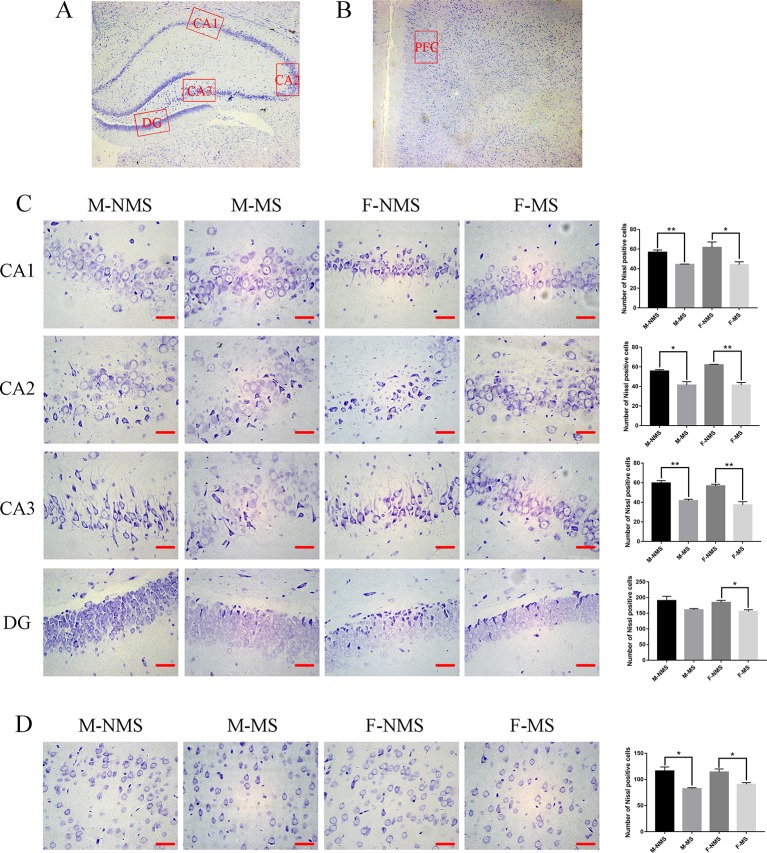
MS decreases the number of neurons. (A) Schematic of the coronal section from rat hippocampus and the locations of CA1, CA2, CA3, and DG regions. (B) The red frame area indicates the field of view of the prefrontal cortex. (C) Representative 400× photomicrographs of Nissl staining in the hippocampal of CA1, CA2, CA3, and DG regions. Results of the number of Nissl staining positive cells in the hippocampal CA1, CA2, CA3, and DG regions are statistically significant, except for the decreasing trend of the M-MS group in the DG region. (D) Representative 400× photomicrographs of Nissl staining in the prefrontal cortex. Statistical results of the number of Nissl-positive cells in the prefrontal cortex. Statistical analyses are performed by two-way ANOVA followed by t-test. Data are presented as mean ± SEM, *p < 0.05, **p < 0.01, n = 3 per group, scale bar = 50 µm.